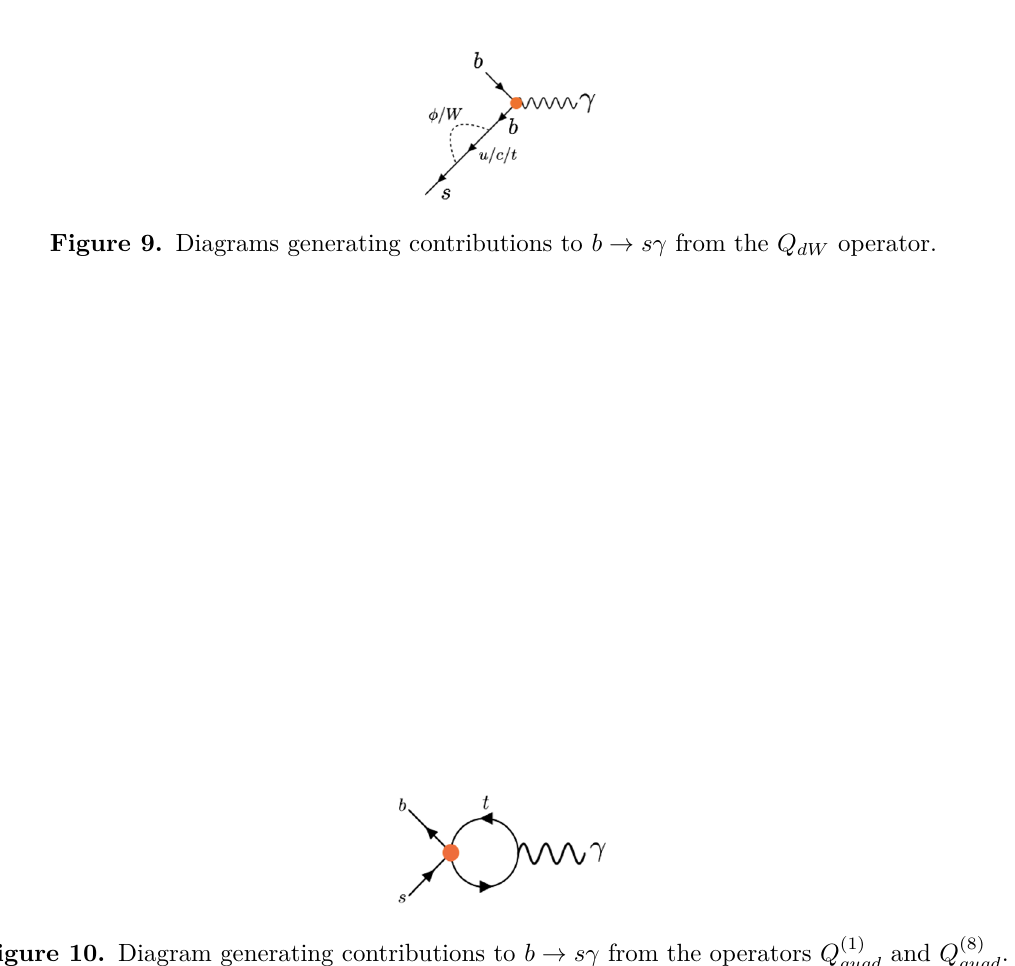
and Q (8) quqd quqd